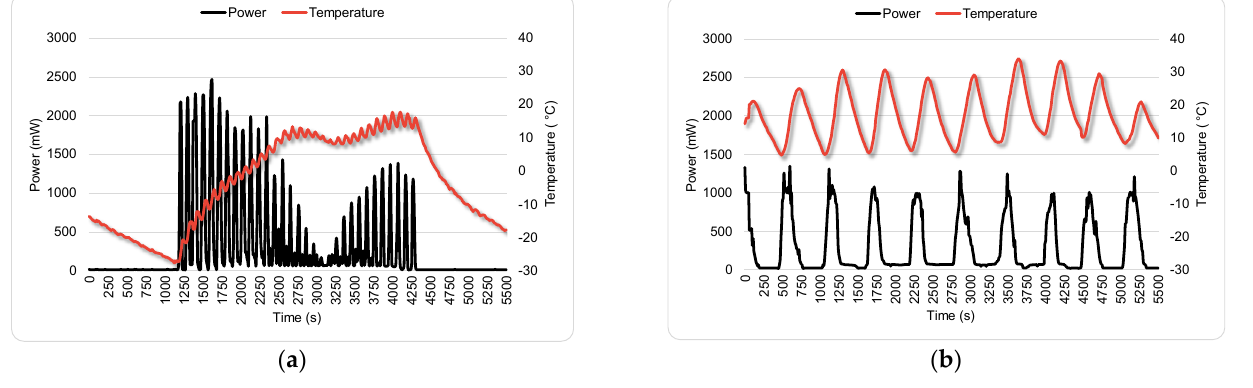
Figure 4. One orbit +Y panel power generation and temperature: ( a ) beta angle 15°; ( b ) beta angle 70°.